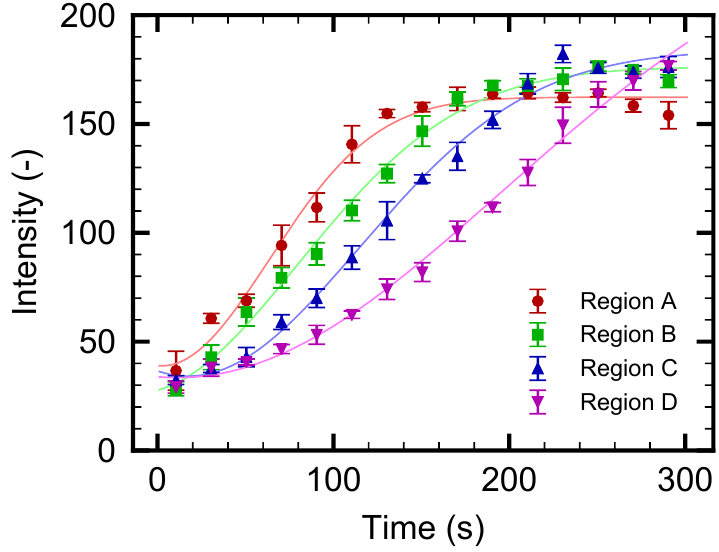
Figure 4. Time-development for fluorescence intensity of microparticles in the regions A, B, C, and D indicated in Figure 3a. The pressure difference ∆ P is set to 1.0